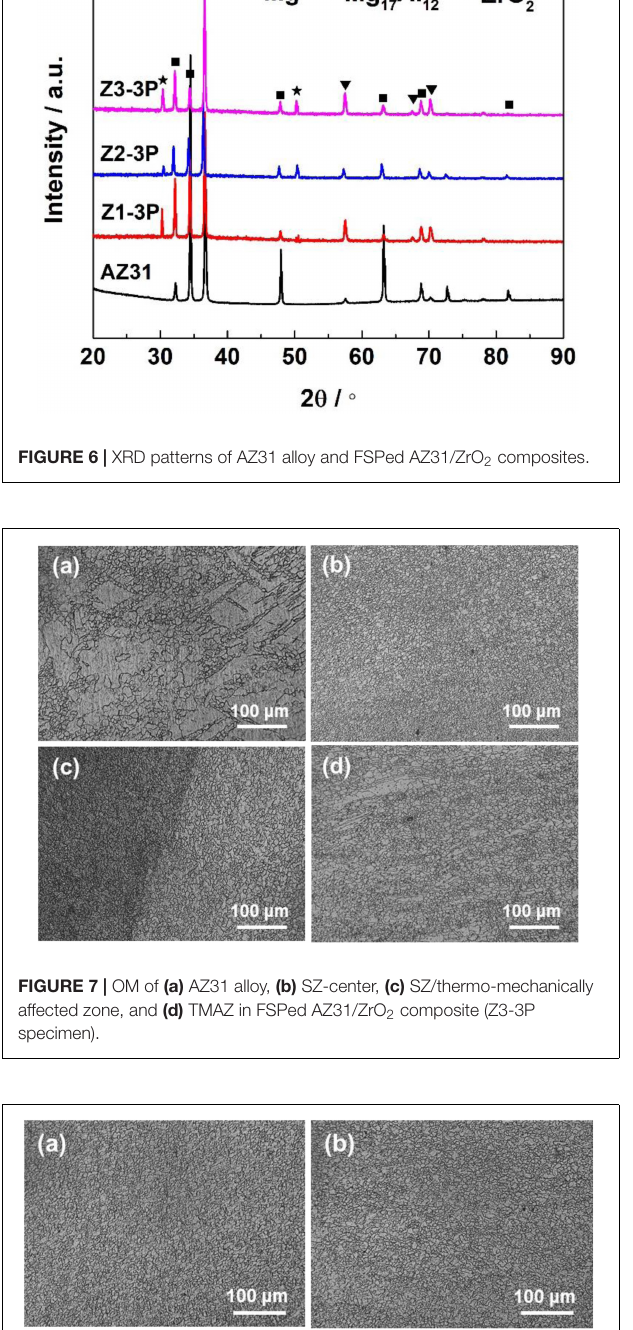
The distance of the layer-to-layer of the ZrO 2 particle is about 0.213 nm. Figure 9d shows the interfacial region between the ZrO 2 particle and the Mg matrix. The excellent interfacial